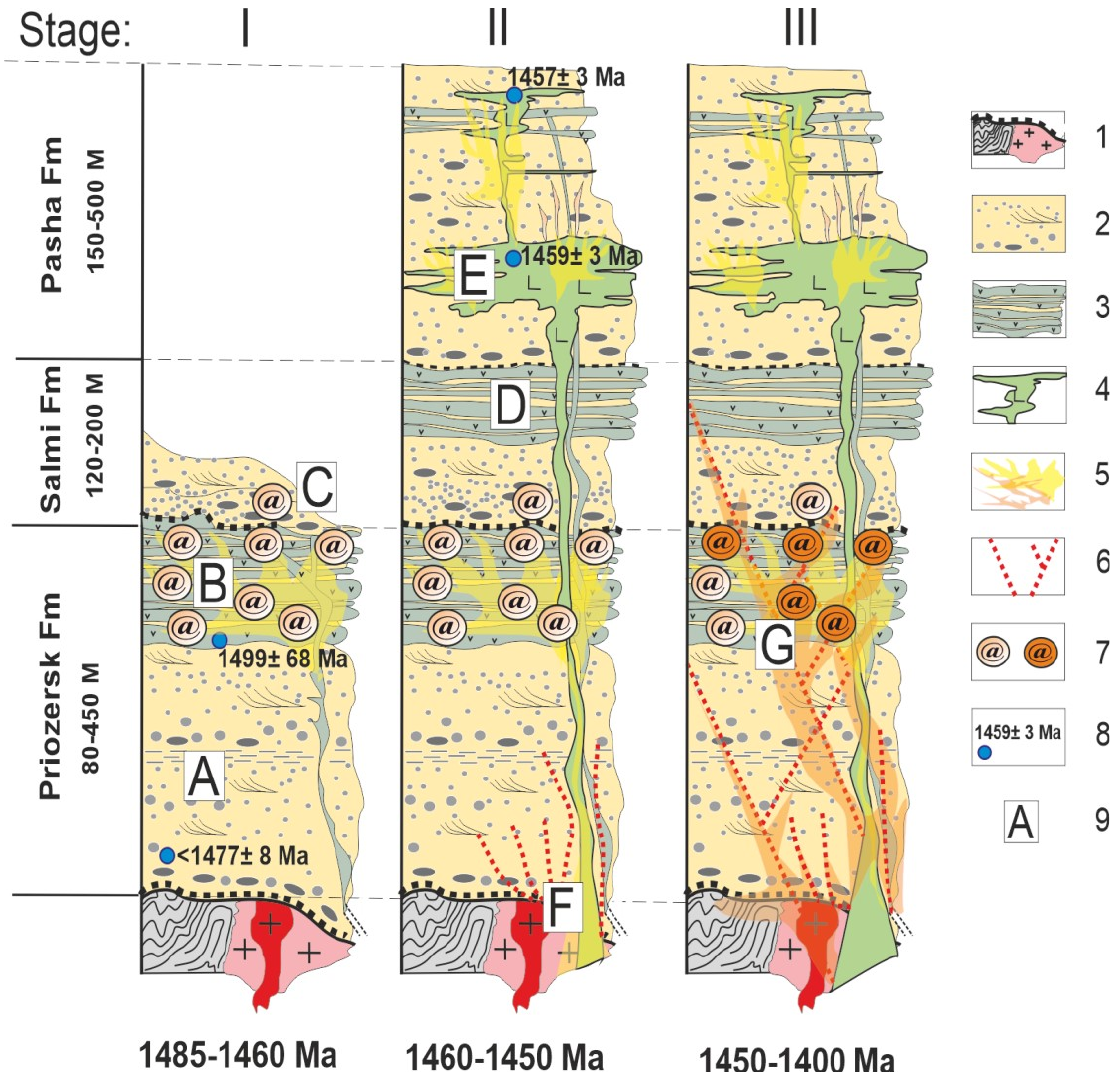
Figure 15. Schematic model of the agate formation stages in the Pasha–Ladoga Basin. Compiled using data from [10] (pp. 74–75), [11] (pp. 145–147), [12], [17] (pp. 49 − 50). Legend: 1, basement rocks; 2, sedimentary successions; 3, volcanic rocks; 4, Valaam sill; 5, post-magmatic and hydrothermal fluids affected zones; 6, tectonic faults, channels of fluid migration; 7, agates, agates; 8, isotope ages; 9, events associated with the agates formation. The black dotted lines indicate profiles of crust of weathering (erosion rocks areas). Stage I: formation of PLB, accumulation of sedimentary rocks of PrF, and appearance of riftogenic volcanics (A); agate formation within PrF volcanics (B); erosion of upper lava flows of PrF and accumulation of sediments of SalF (C). Stage II: formation of volcanic-sedimentary complexes of SalF and PashF (D); intrusion of gabbro-dolerite sill (E); formation of tectonically permeable zones at the PLB basement and remobilazation of iron compounds from the crust of weathering (F). Stage III: top-up of previously formed agates and mineralization of gas vesicles by hematite-rich calcite/silica matter